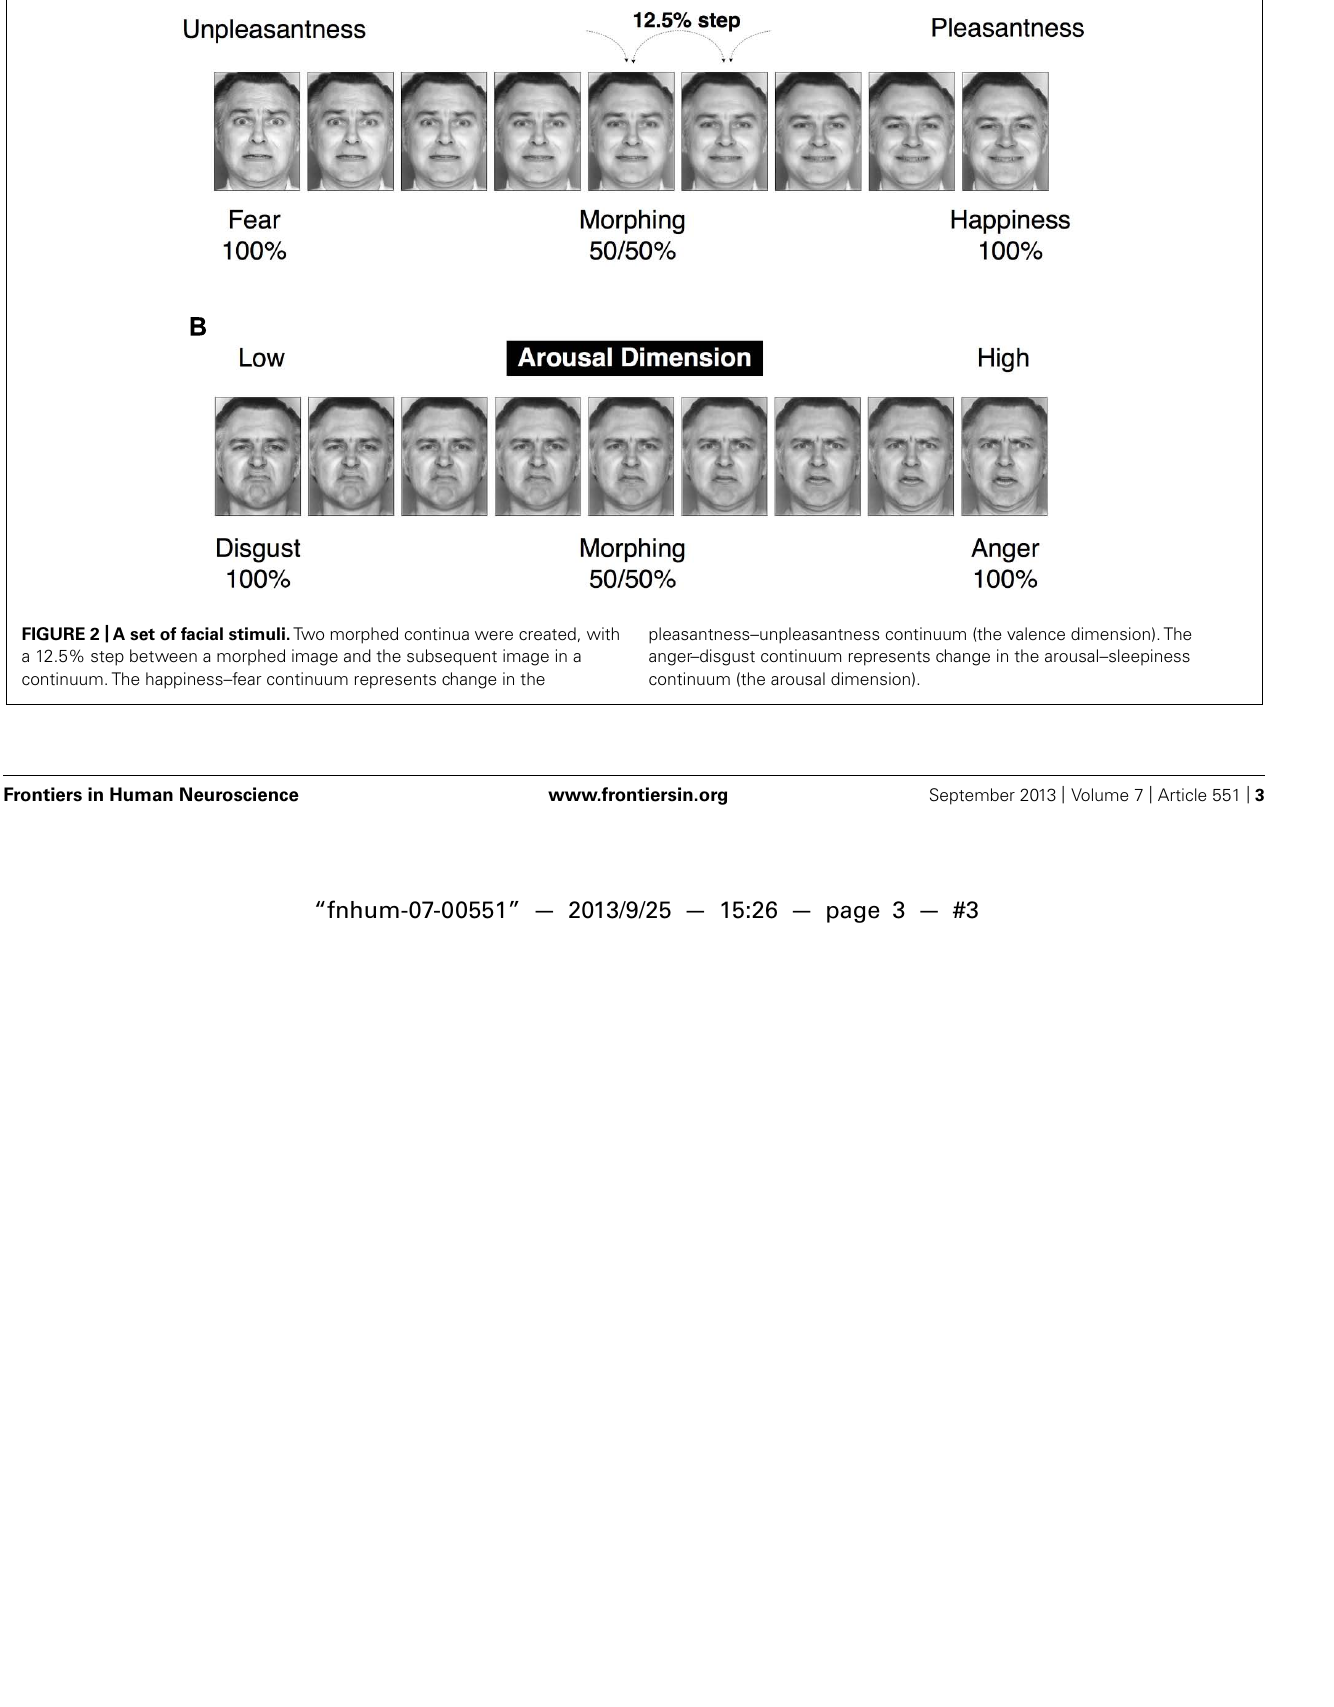
FIGURE 2 |A set of facial stimuli. Two morphed continua were created, with a 12.5% step between a morphed image and the subsequent image in a continuum.The happiness–fear continuum represents change in the